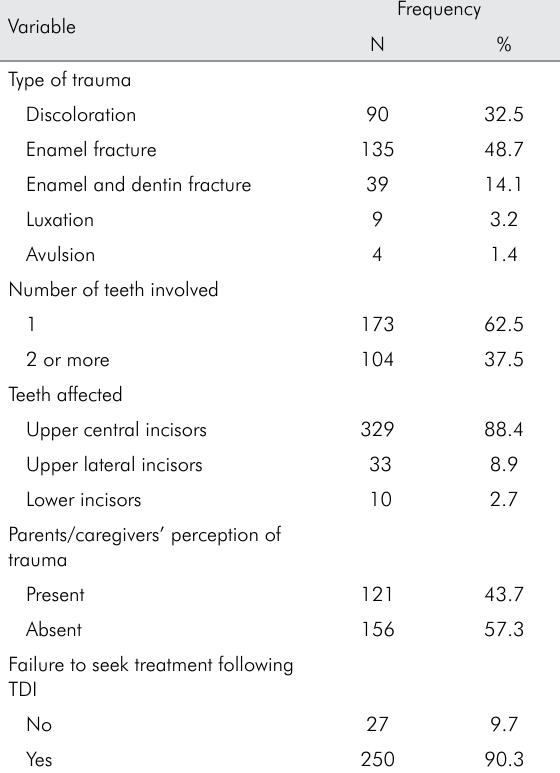
Table 2. Frequency distribution of preschool children ac- cording to type of trauma, number of teeth involved, teeth affected, parents/guardians’ perception of trauma and fail- ure to seek treatment following